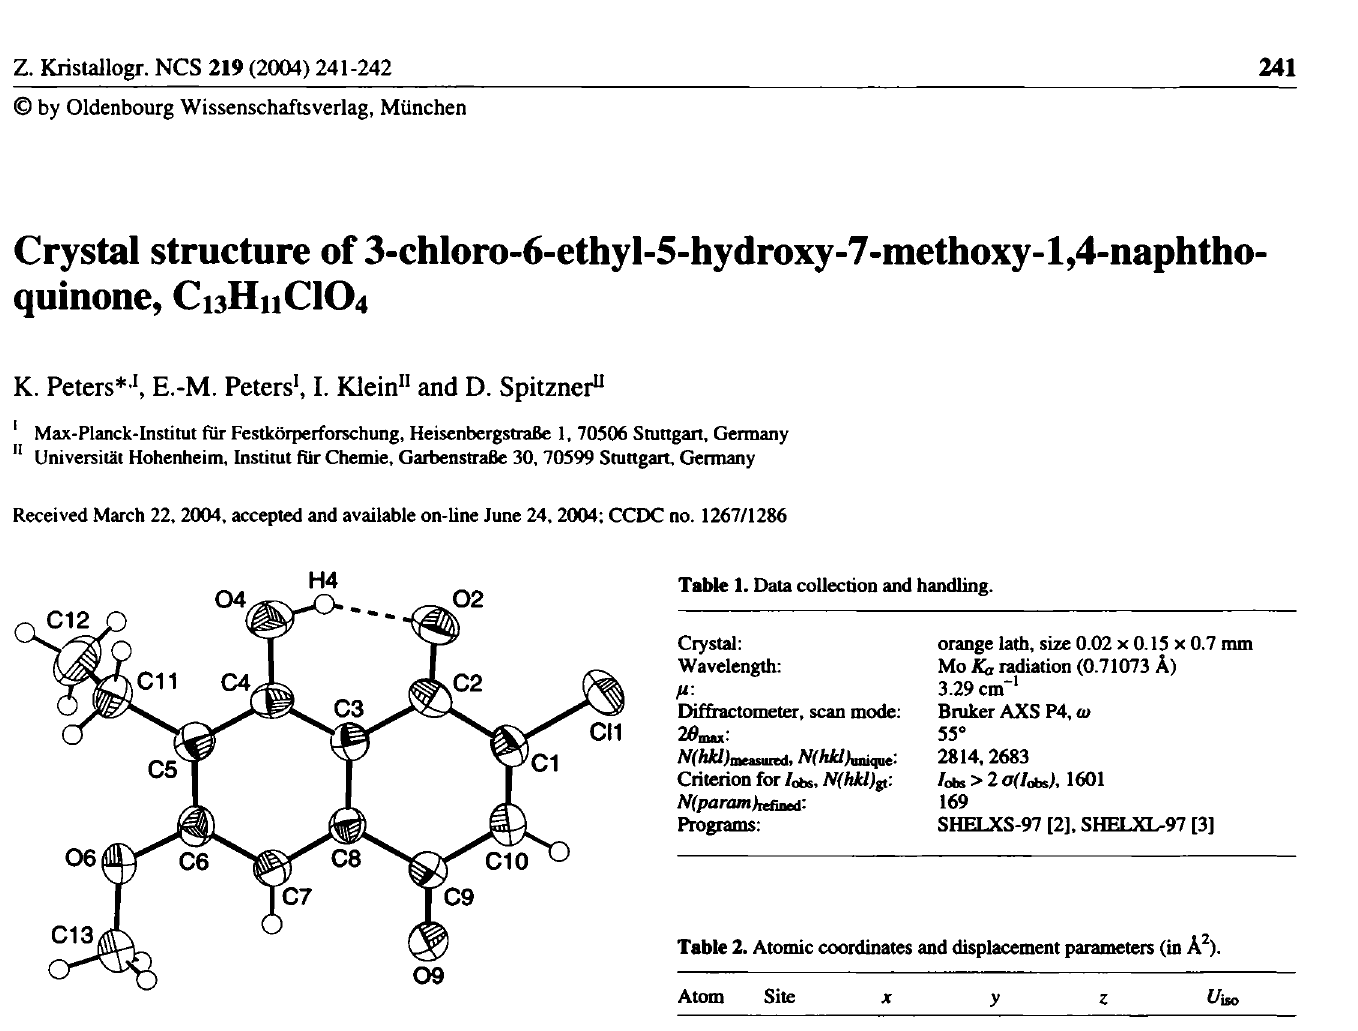
Table 2. Atomic coordinates and displacement parameters (in Ä 2 ).